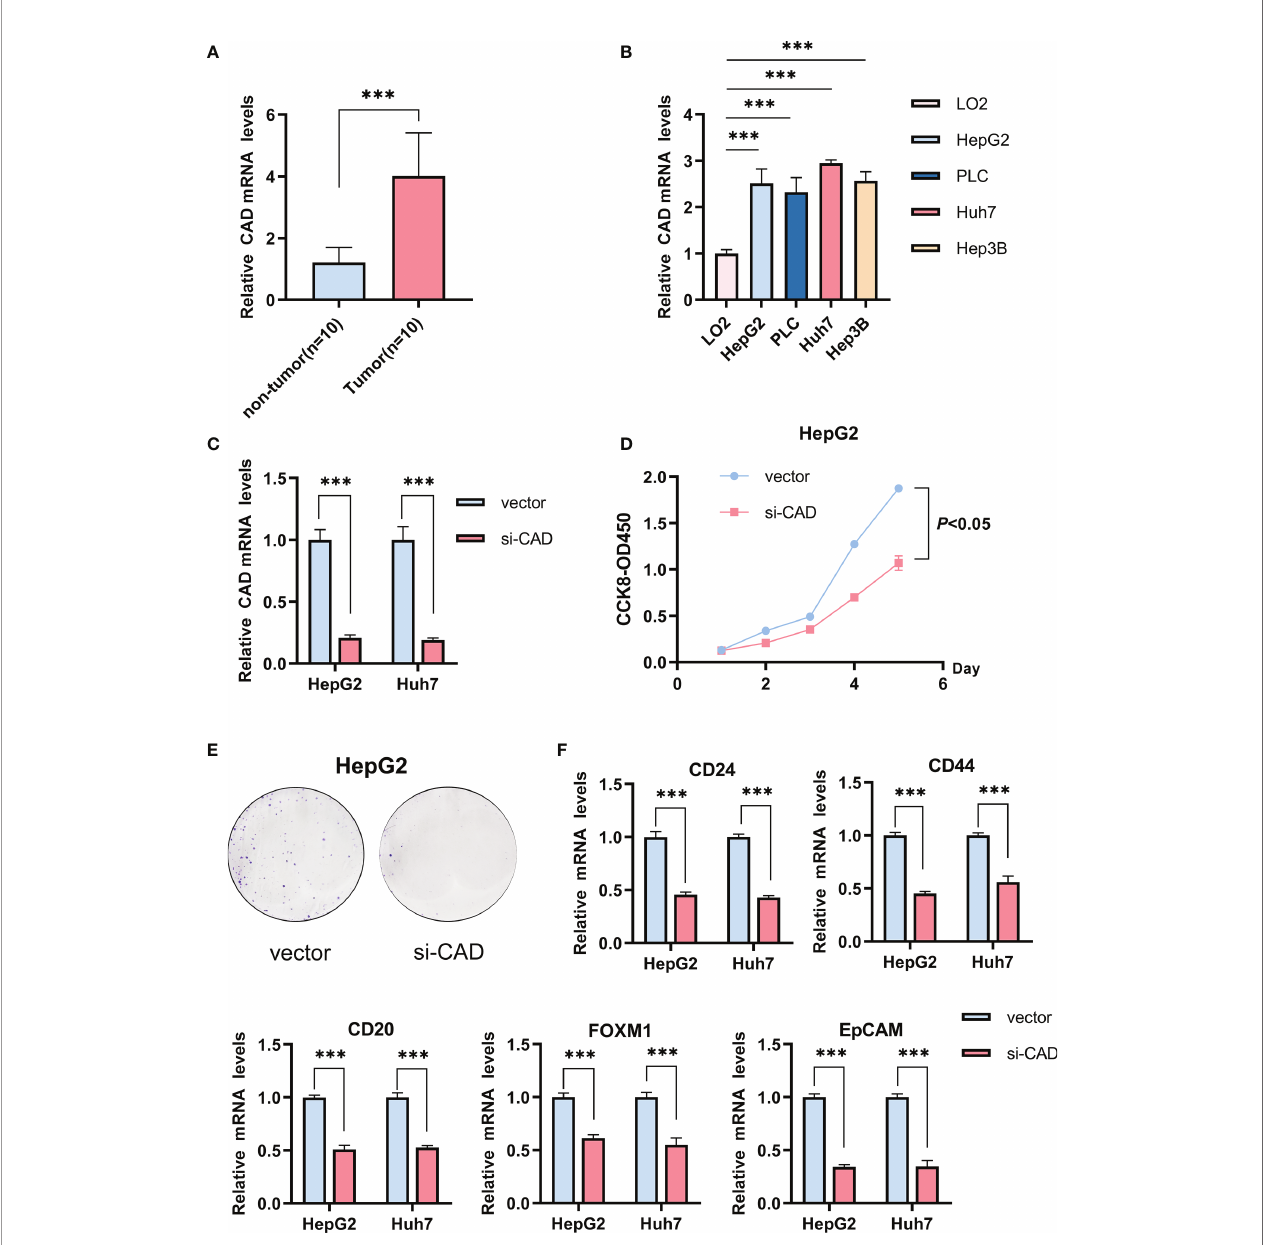
FIGURE 5 | The in fl uence of CAD on the HCC stemness phenotype. (A) Differences in CAD expression between normal and HCC tissues. (B) Differential expression of CAD in HCC and normal cells. (C) The ef fi ciency of CAD knockdown in HepG2 and Huh7 cells. (D) CCK-8 experiment comparing the si-CAD and control groups in HepG2 cells. (E) Colony formation assay comparing the si-CAD and control group in HepG2 cells. (F) Signi fi cant decrease in stemness-related markers, CD24, CD44, CD20, FOXM1, and EpCAM, after CAD knockdown in HepG2 and Huh7 cells. *** P <